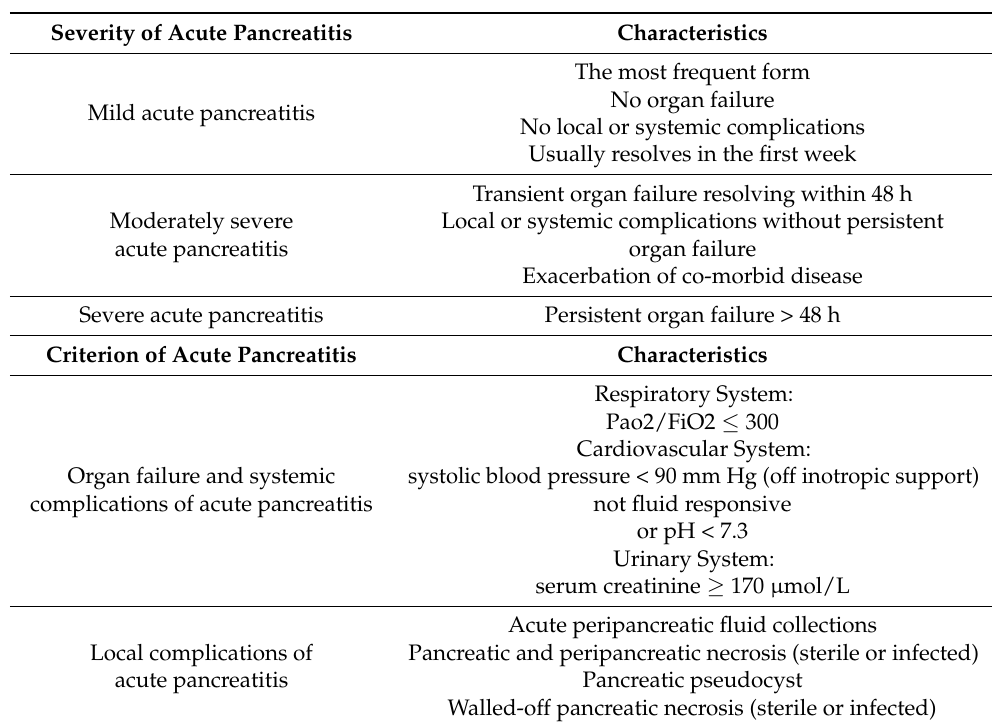
Table 1. Classification of acute pancreatitis based on the 2012 Atlanta Classification of Acute Pancre- atitis. Explanation of crucial